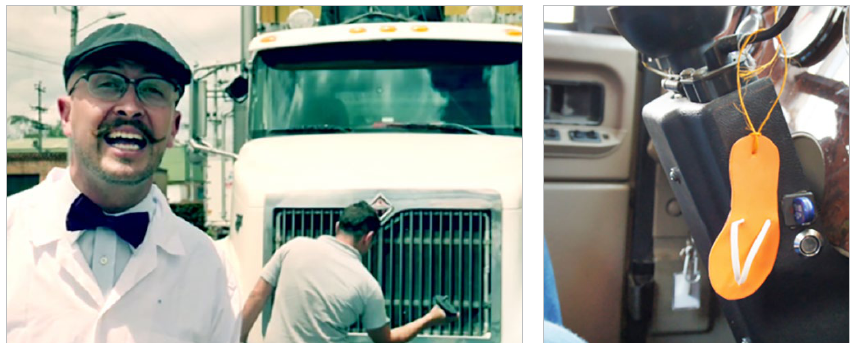
Figure 1. The EBO(R/I) intervention (a subtitled video version can be accessed here: https: // youtu.be / wylYeNZWpSQ